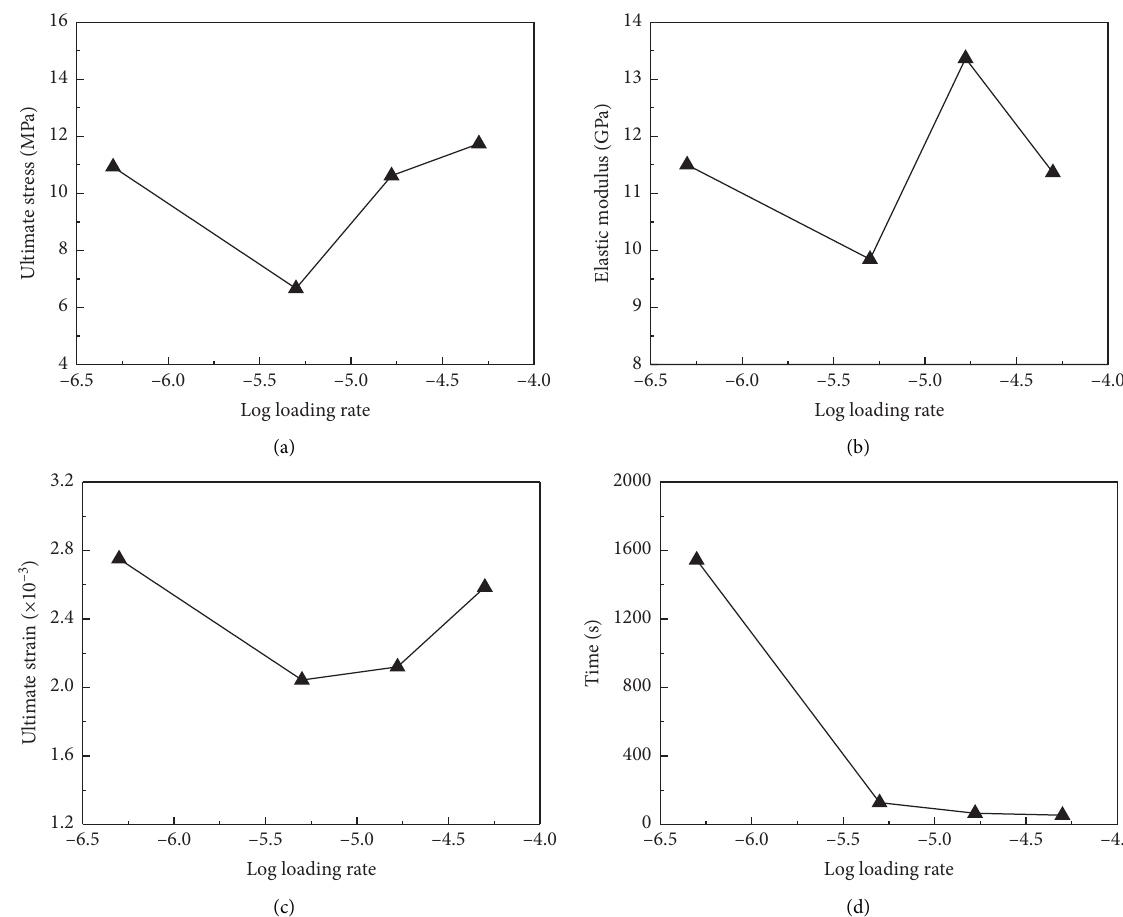
Figure 5: Mechanical characteristic curves under different loading rates: (a) the relationship between ultimate stress and loading rate; (b) the relationship between elastic modulus and loading rate; (c) the relationship between ultimate strain and loading rate; (d) the relationship between time and loading rate.